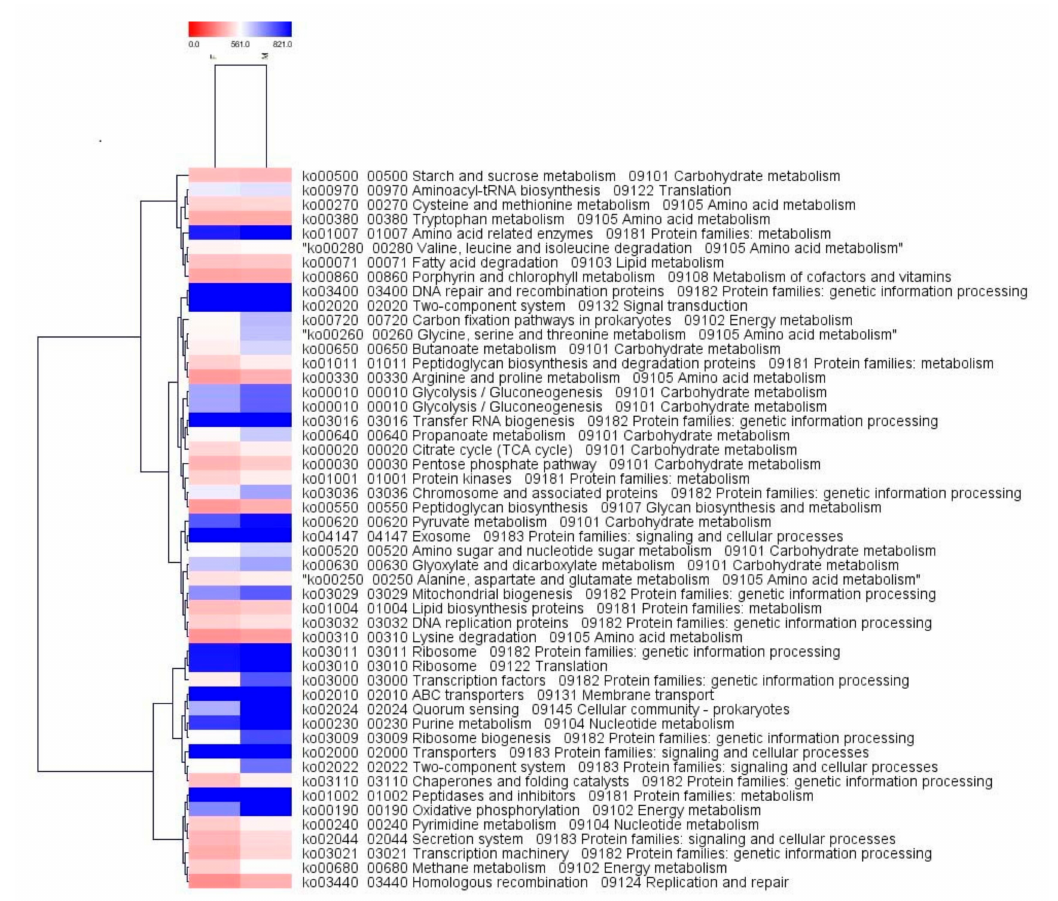
Figure 6. Heat tree of the top 50 common KEGG (Kyoto Encyclopedia of Genes and Genomes) pathways using the MeV tool for lentil cultivars Moitree (M) and Farmer-2